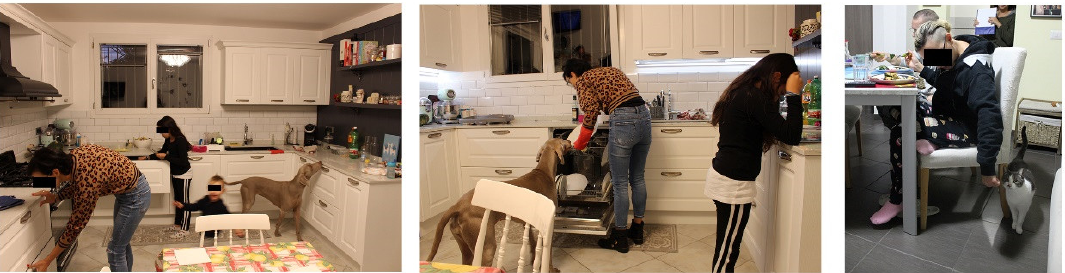
Figure 6. Management of pets in the kitchen.